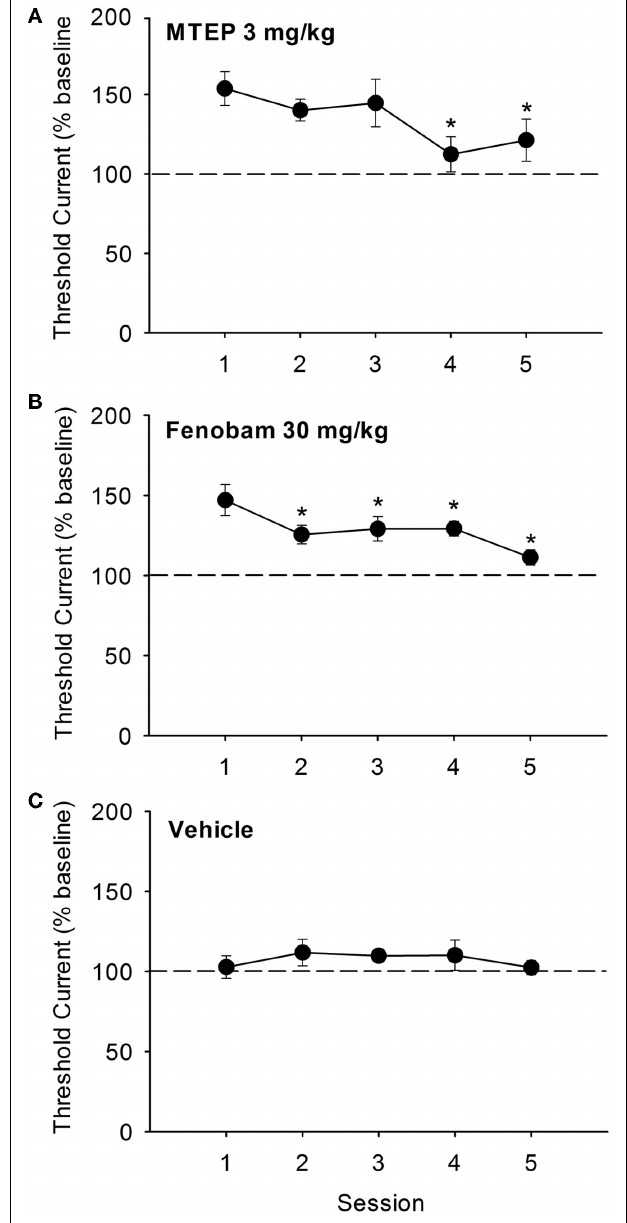
FIGURE 3 | Effects of repeated administration of MTEP [(A): 3mg/kg, n = 12], fenobam [(B): 30mg/kg, n = 9], or vehicle [(C): n = 4] for five consecutive threshold determination sessions conduced once daily. * P < 0.05 vs. Session